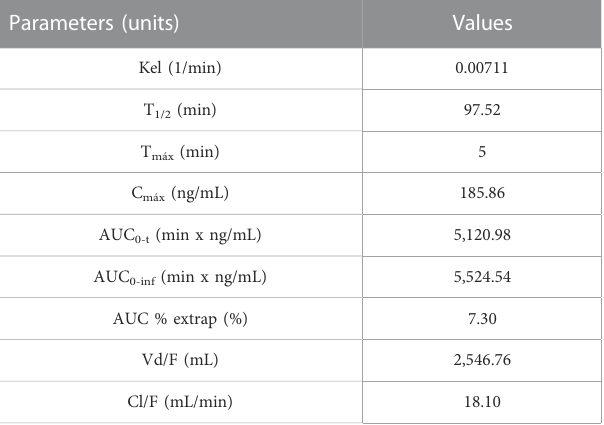
TABLE 4 Pharmacokinetic parameters of 2 9 -hydroxy fl avanone (2HF). Parameters